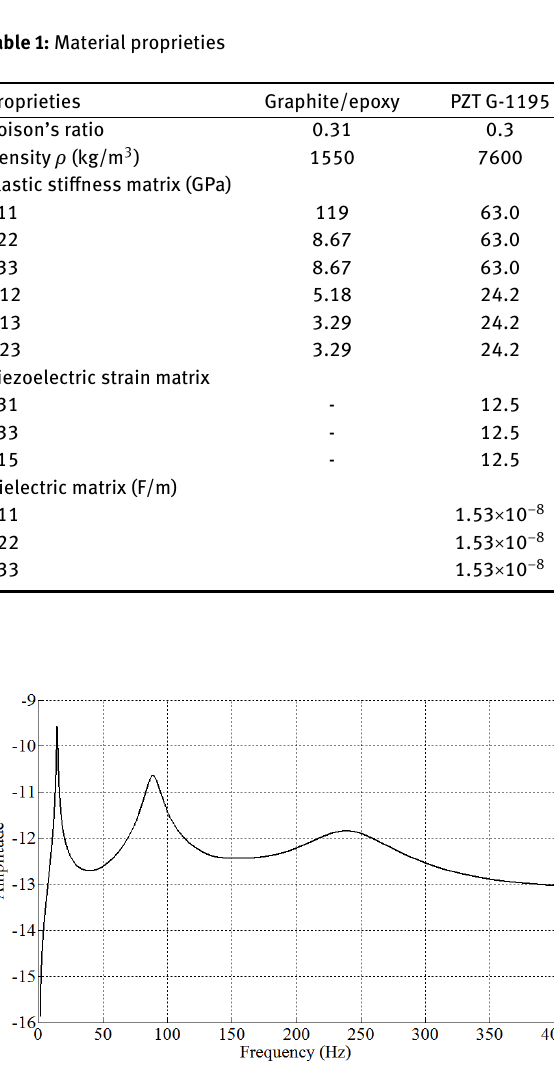
Figure 1: Frequency response